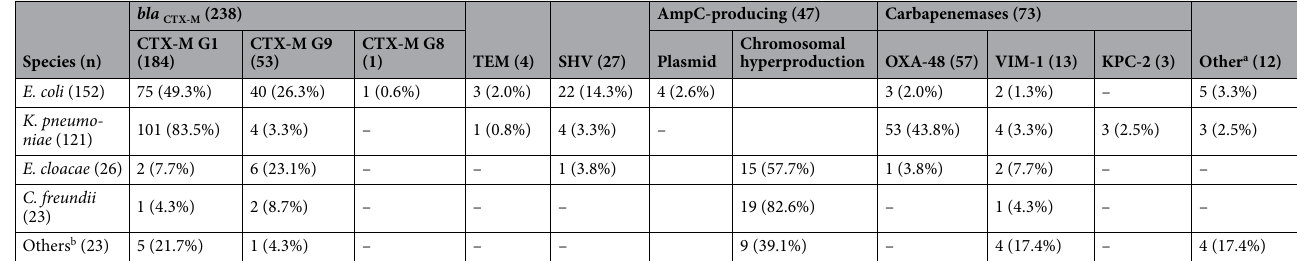
Table 3. Distribution of antibiotic resistance genes encoding ESBLs, AmpC and carbapenemases detected in 345 MDR-E isolates from patients with kidney, liver or combined kidney/pancreas transplant. a Other mechanisms were: SHV-1 hyperproduction (4 strains), TEM-1 hyperproduction (4 isolates) and OXA-1 production (4 strains). b Other species included: 7 K . oxytoca , 6 M . morganii , 4 E. aerogenes , 2 P. mirabilis , 2 C. braakii , 1 E. asburiae and 1 C.